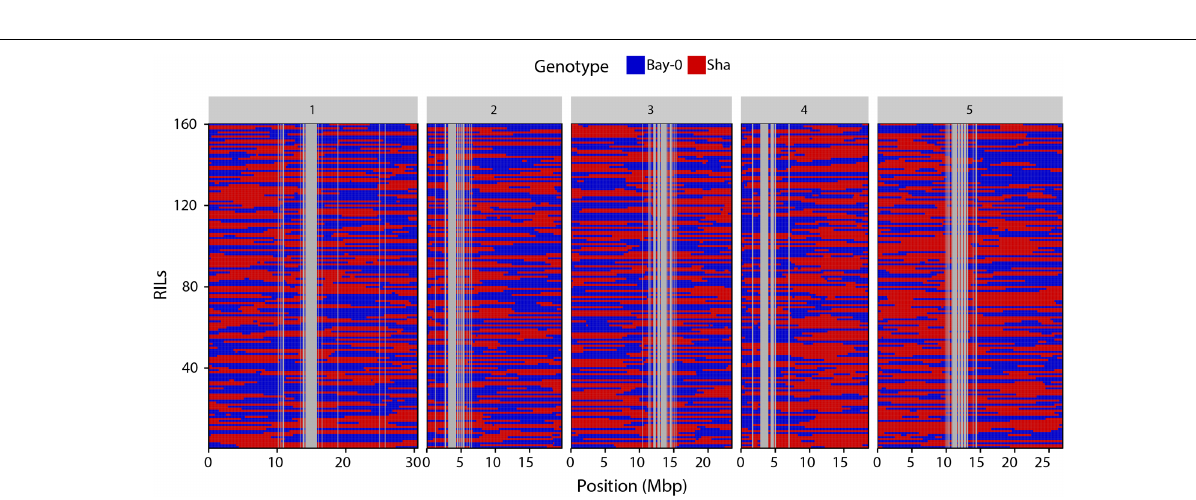
Frontiers in Genetics |